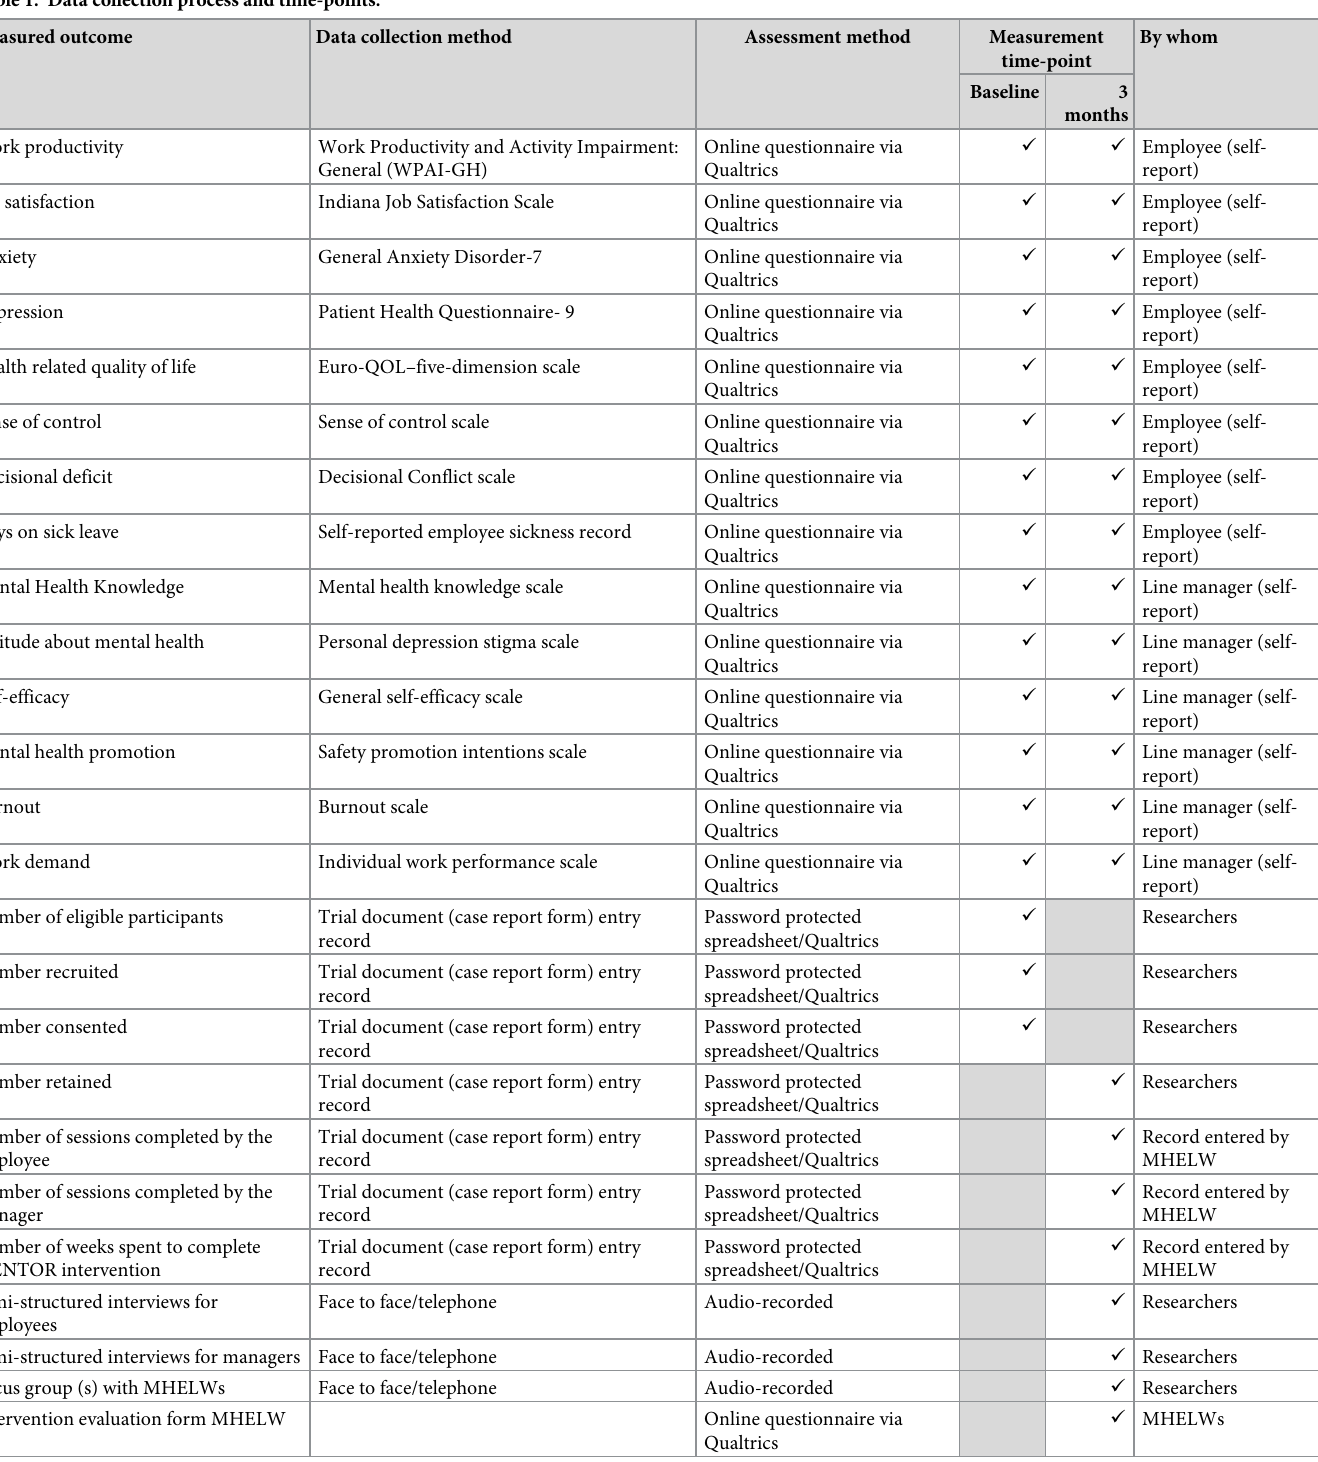
Table 1. Data collection process and